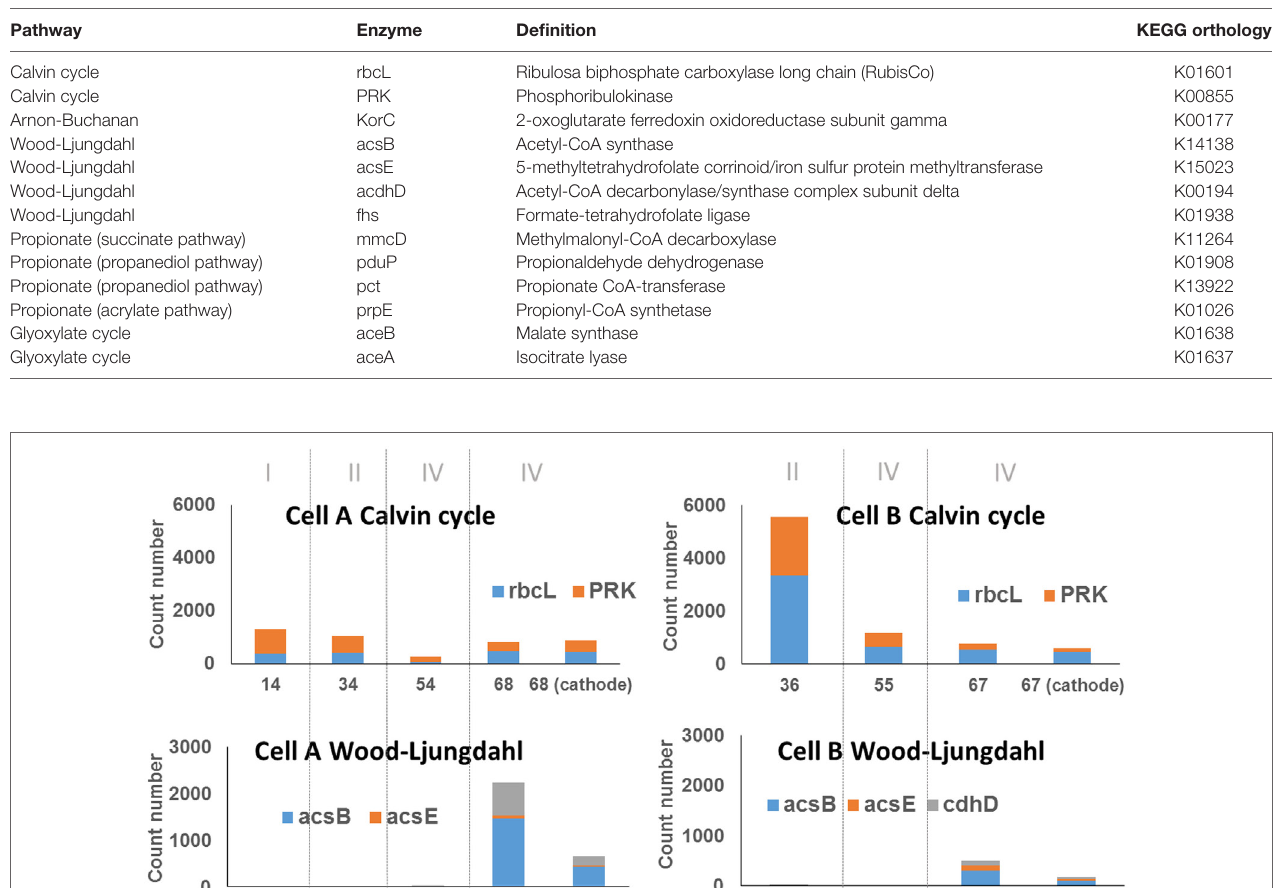
TaBle 3 | Metabolic pathways (key enzymes) evaluated via